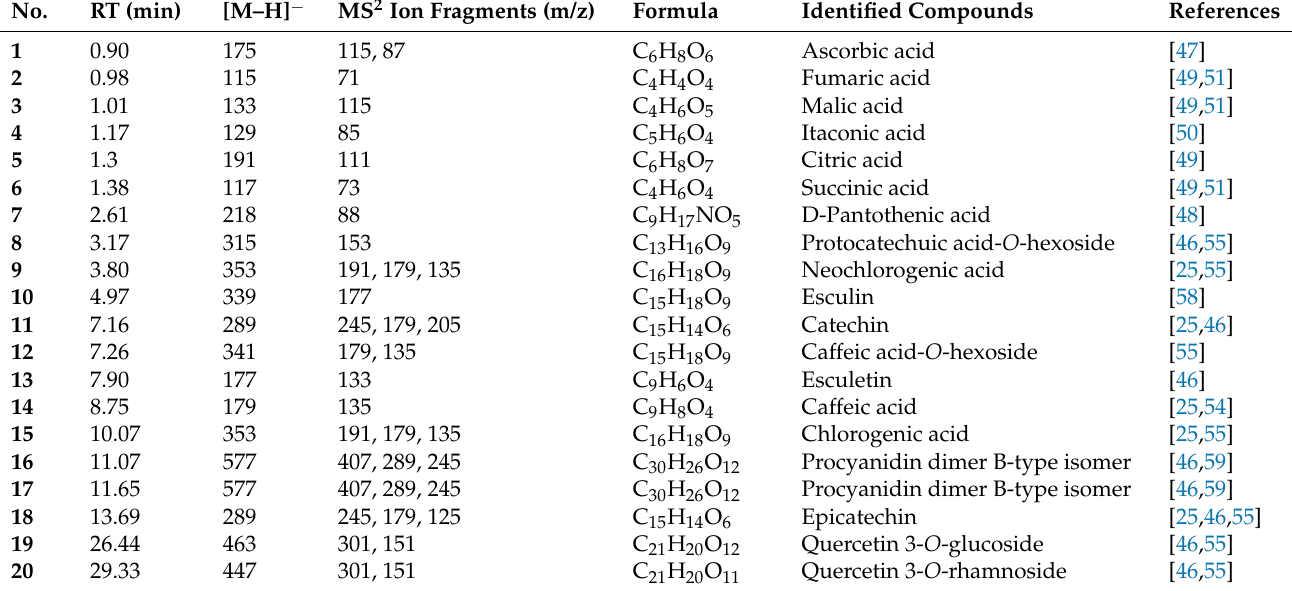
Table 5. Tentative identification of phytochemical compounds in kiwifruit by using